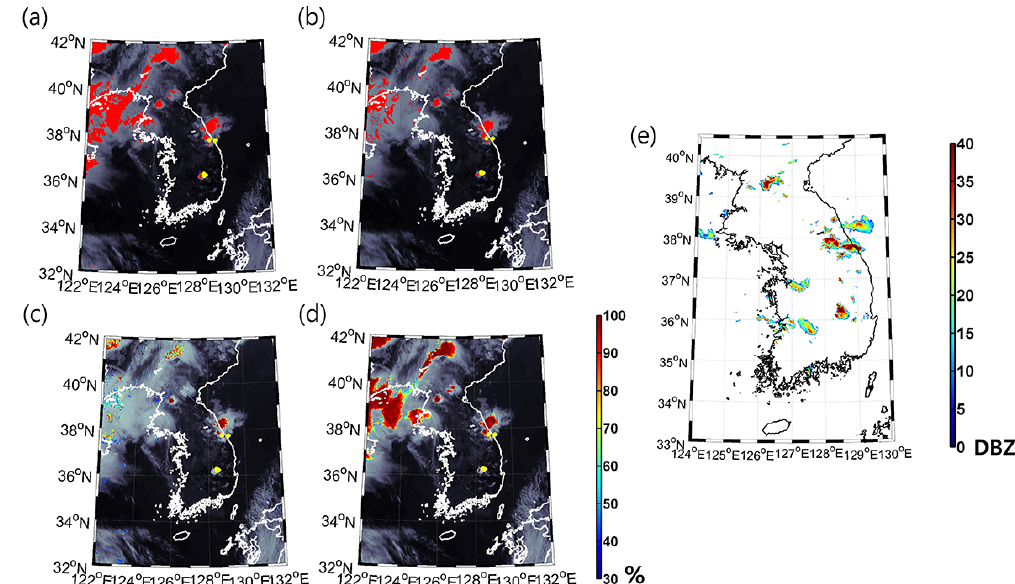
Figure 10. Deterministic CI detection map derived by DT, RF, probabilistic RF, and LR on 30 June 2016 at 08:00 (UTC): (a) DT, (b) RF, (c) probabilistic RF, and (d) LR 40min before CI occurrence. Panel (e) is the 1.5km radar CAPPI image at 08:40 (UTC). While predicted CI is in red, the locations of lightning occurrences at 08:00 (UTC) are presented in yellow